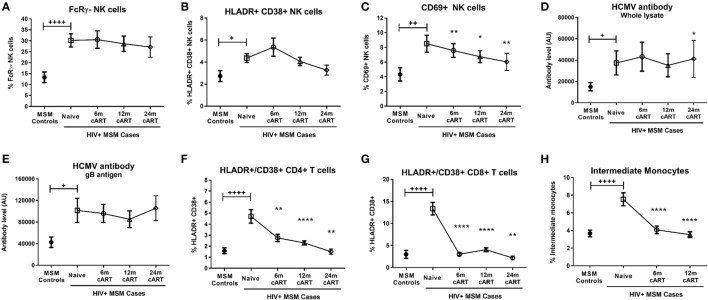
Combination antiretroviral therapy (cART) reverses T cell and monocyte activation, but not NK cell dysfunction or human CMV (HCMV) antibody levels. The proportion of FcRγ− NK cells (A), activated HLA-DR+CD38+
(B), and CD69+
(C) NK cells, plasma levels of HCMV-specific antibodies to either whole HCMV lysate (D) or gB antigen (E), the percentage of activated HLA-DR+CD38+ CD4+
(F) and CD8+
(G) T cells and the proportion of intermediate (CD14++CD16+) monocytes (H) was determined in HIV-uninfected MSM (n = 15) and HIV+ MSM (n = 20) at baseline (cART-naïve) and after 6, 12, and 24 months of cART. Graphs show median and IQR. +, ++, and ++++ denote p < 0.05, 0.01, and 0.0001, respectively, as compared to HIV− MSM determined by Mann–Whitney U test. *, **, and **** and denote p < 0.05, <0.01, and <0.0001, respectively, as compared to the corresponding cART-naïve value determined by Wilcoxon matched pairs signed rank test. AU, arbitrary units.